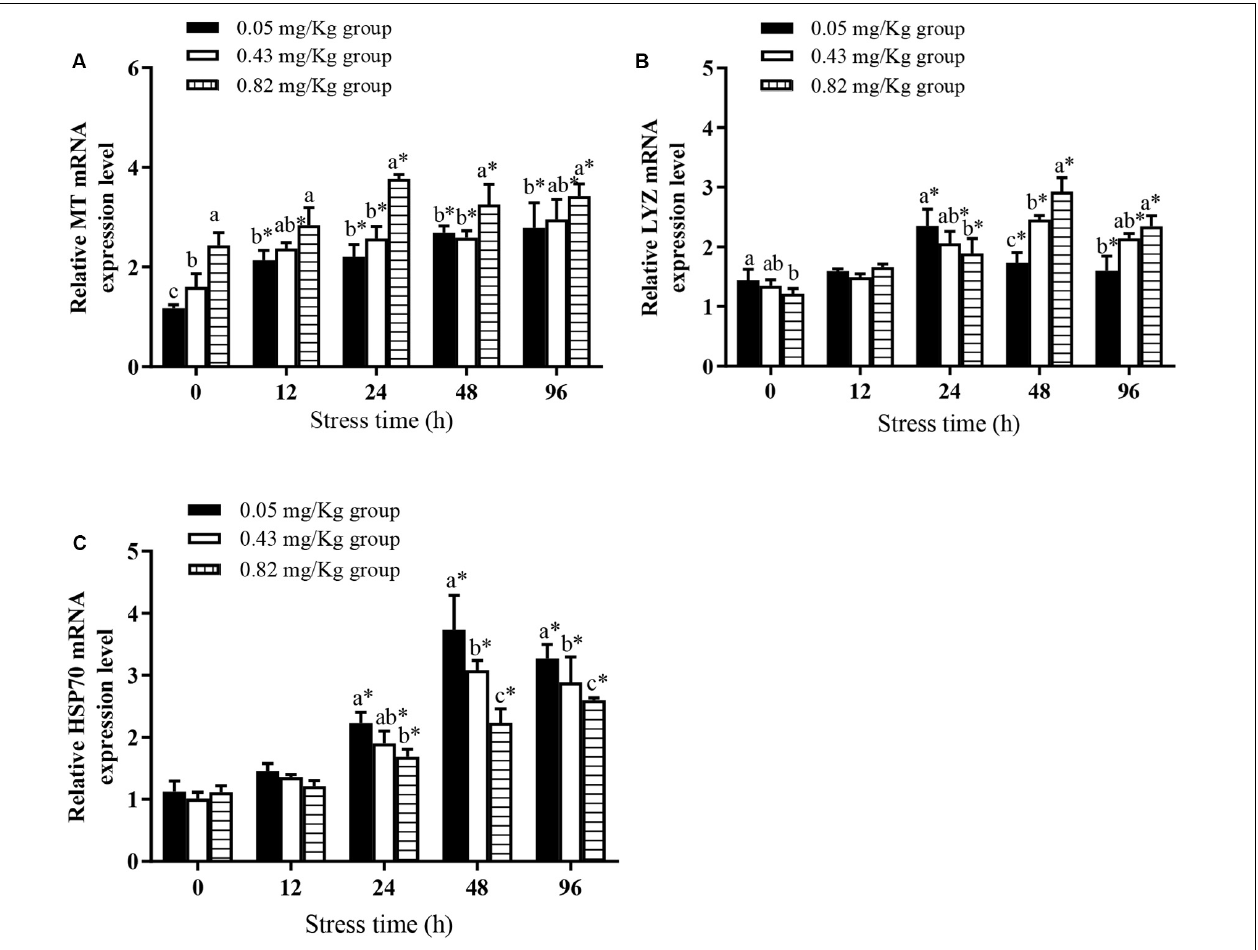
FIGURE 2 | Effects of dietary supplementation with Se-cultured P. maackianus powder on MT (A) , LYZ (B) , and HSP70 (C) gene expression of Chinese mitten crab ( E. sinensis ) and its response under Cu 2 + stress ( N ≥ 9). This study is divided into 3 experimental groups, adding 0.05, 0.43, and 0.82 mg/kg Se to the feed. After 60 days of rearing experiment, hepatopancreas tissues of 10 fish were taken for determination of MT , LYZ , and HSP70 gene expression. At 12, 24, 48, and 96 h of Cu 2 + stress, nine crabs in each experimental group were randomly selected, and their hepatopancreases were taken for determination of MT , LYZ , and HSP70 gene expression. ∗ indicates significant differences between values obtained before and after injection (paired-samples t test; P < 0.05). Different lowercase letters show significant differences among different treatments at each sampling point (Duncan’s multiple range test; P <